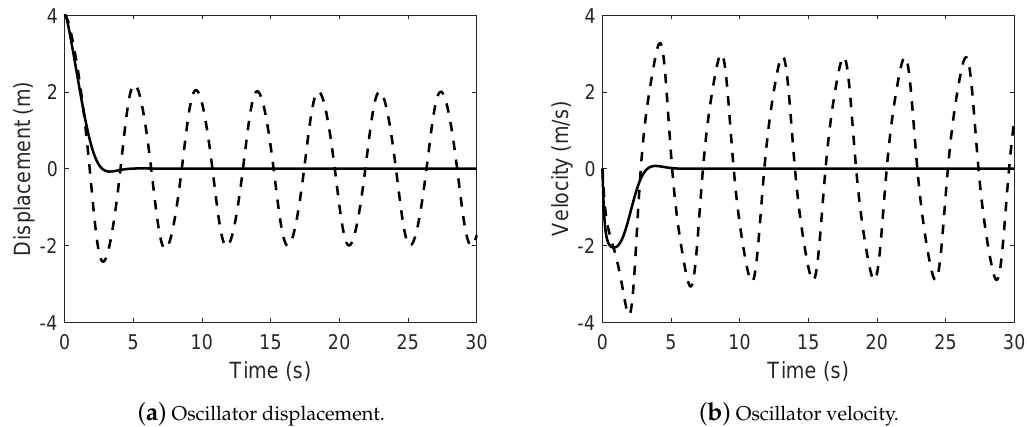
Figure 7. Uncontrolled motion (dashed line) and feedback controlled motion (solid line).